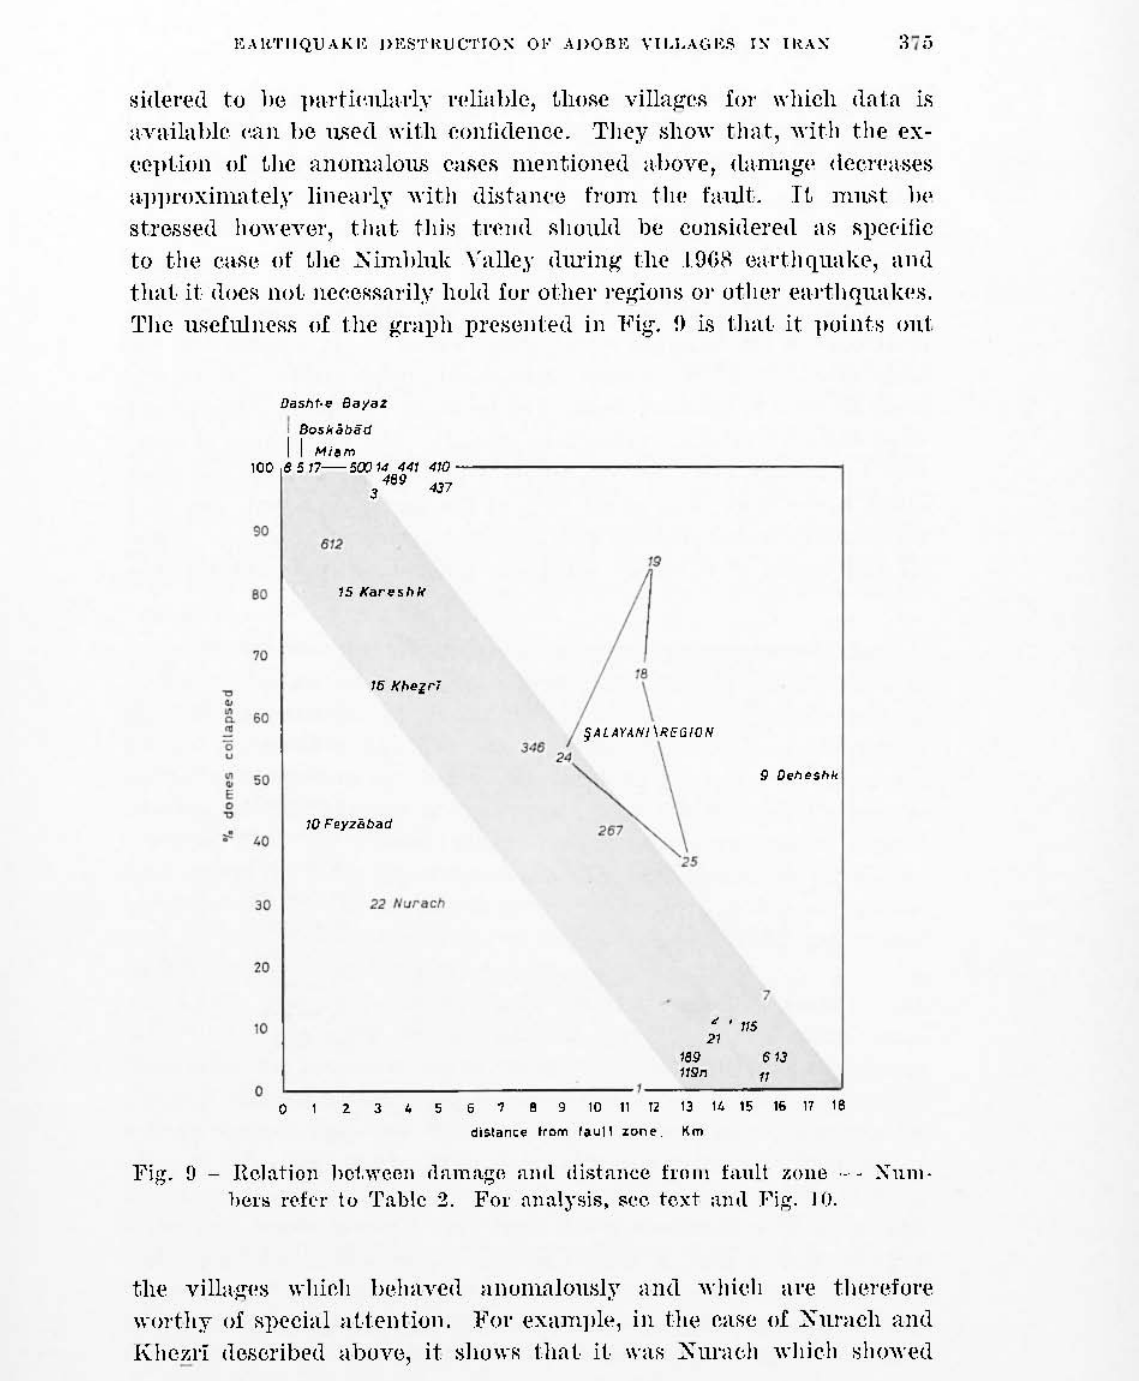
Fig. !J - He1atioll hc1.wcclI t1amage alll1 distallce frntl! falllt ZOlle .. "